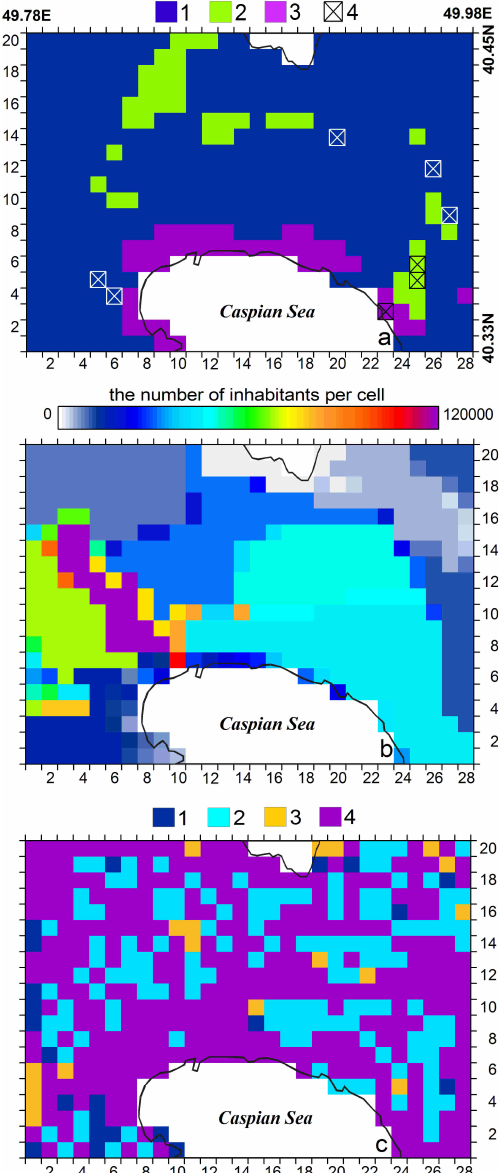
Fig. 8. Cell models of vulnerability and exposure. ( a ) Soil types. 1: the Quaternary sand, clay, intrusions of limestone, and sandy clay; the Upper Tertiary limestone and sandstone (minor amplification of shaking). 2: the Quaternary sand, gravel-pebble, and limestone with clay intrusions (moderate amplification of shaking). 3: water- saturated sand, clay and rubble (significant amplification of shak- ing). 4: landslide area. ( b ) Distribution of urban population. ( c ) Distribution of exposure. 1: low-value objects; 2: moderate-value objects; 3: high-value objects; and 4: very-high-value objects.